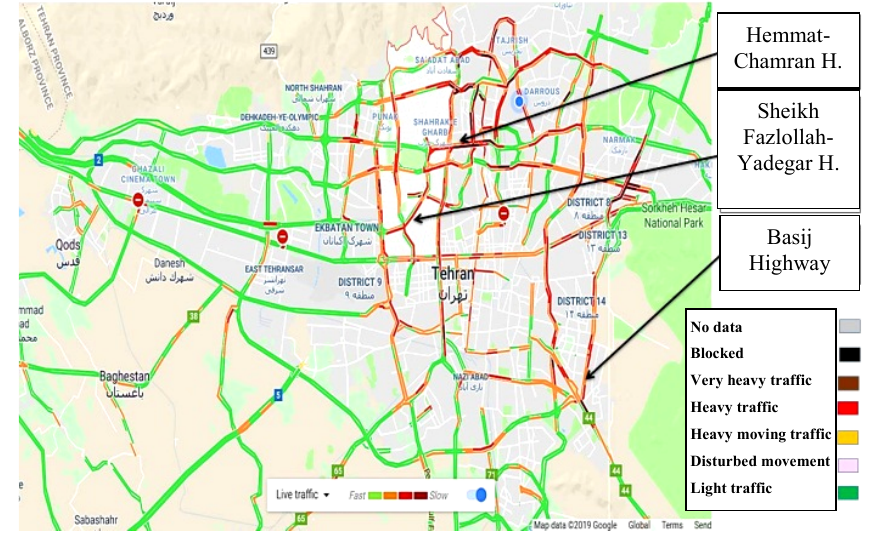
Figure 2. Online traffic map of Tehran City, Winter 2018 [22]